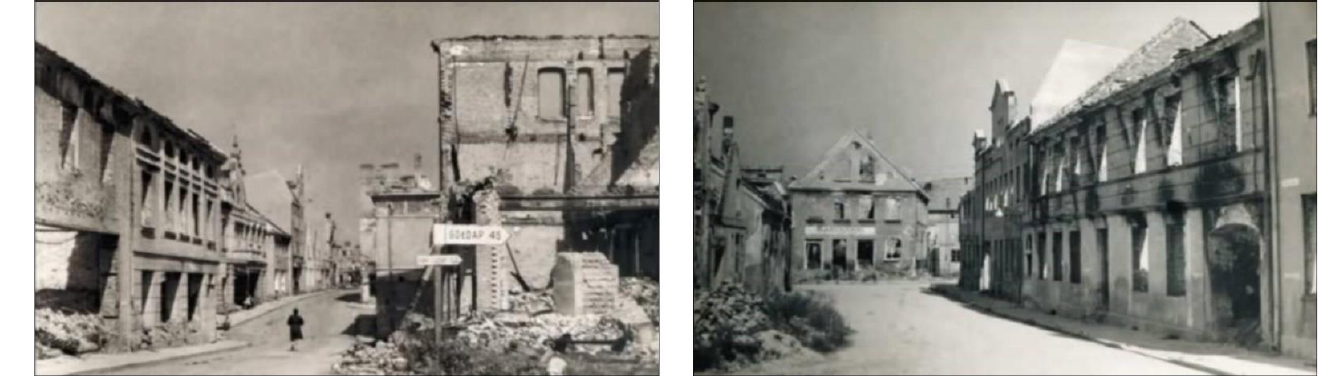
Figure 3. View of the town center, 1945. Source: Photo Archive — East Prussia [105].